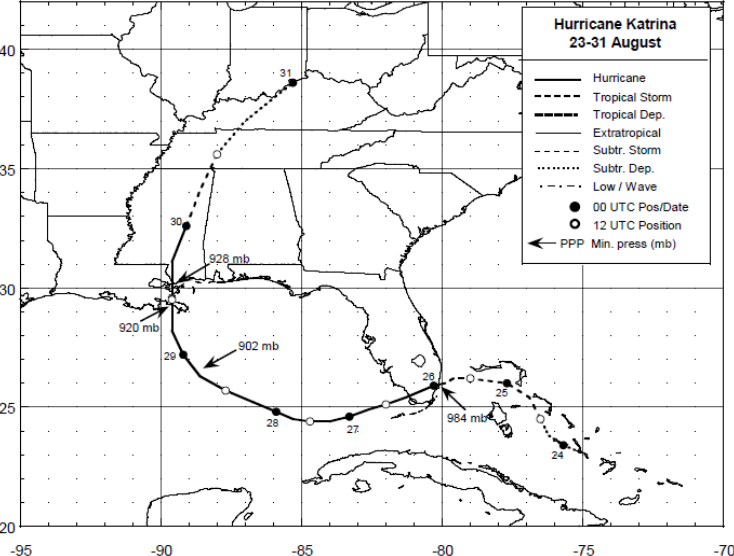
Figure 5. Sea Level Pressure variations of Hurricane Katrina during 23–30 August 2005. Selected pressure observations and best track minimum central pressure curve taken form NHC